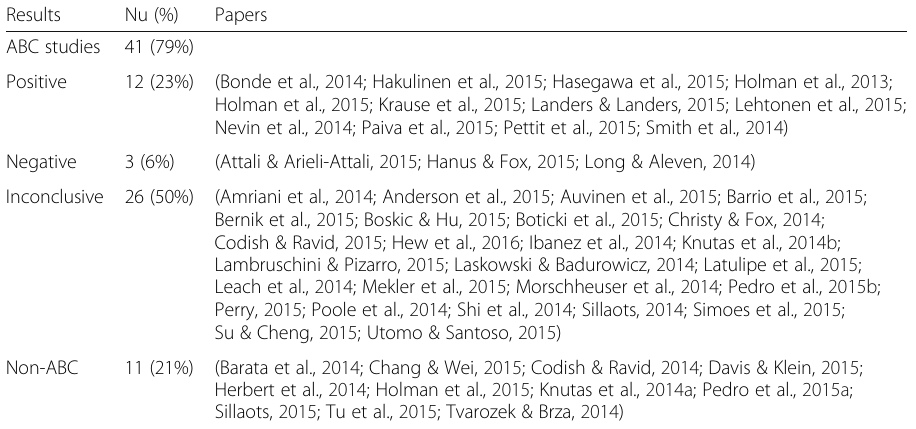
Table 9 Categorizations of the Studies based on the outcomes and presented degree of evidence Results